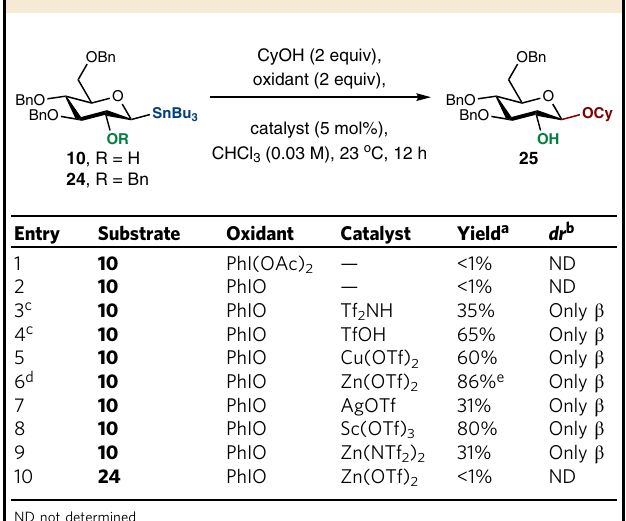
Table 2 Optimization of oxidative glycosylation with anomeric